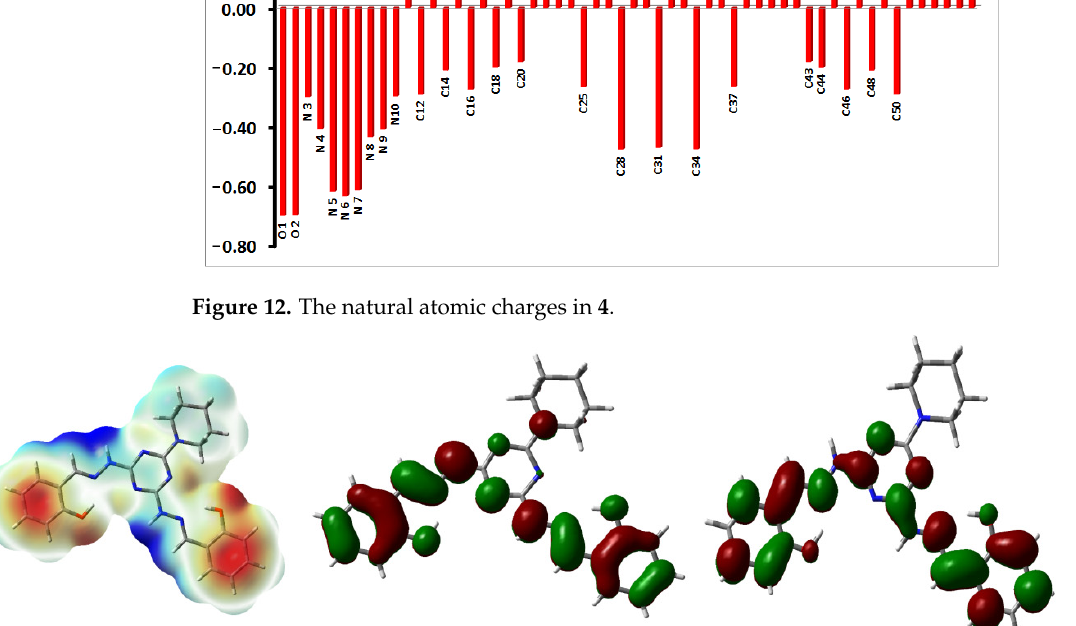
Figure 13. The MEP, HOMO, and LUMO of 4 .